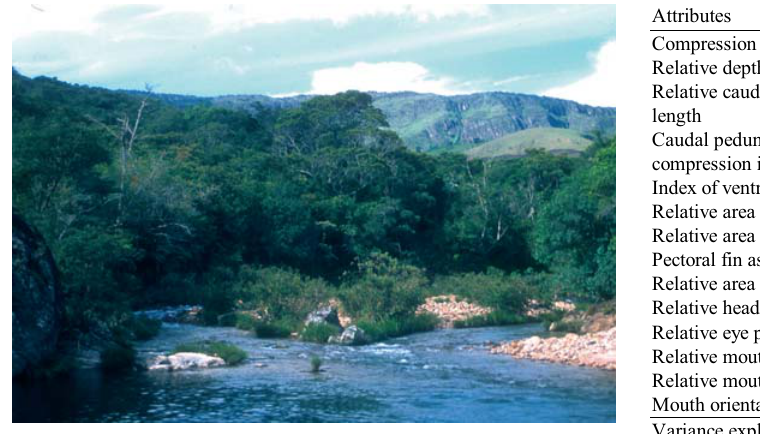
Fig. 1. General view of the studied riffle stretch (20º30’S 46º50’W) in the upper rio São Francisco, southeastern Brazil (photo: Ricardo